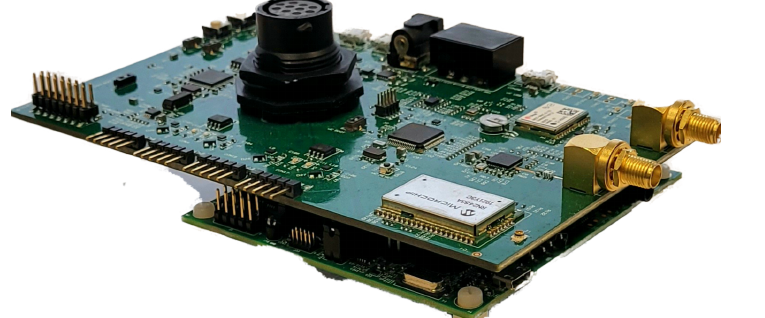
Figure 4. Photograph of the designed